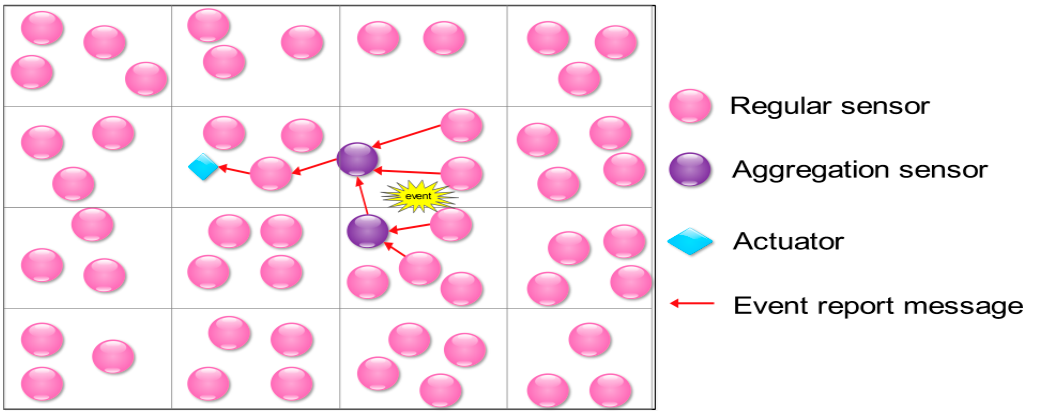
Figure 2. Data aggregation and transmission in the framework proposed in [45].